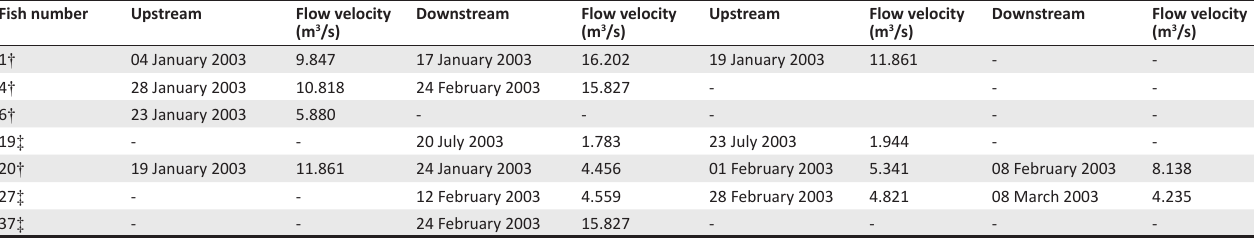
TABLE 3: Successful crossings of radio-tagged tigerfish at the Kruger National Park weir. Fish number